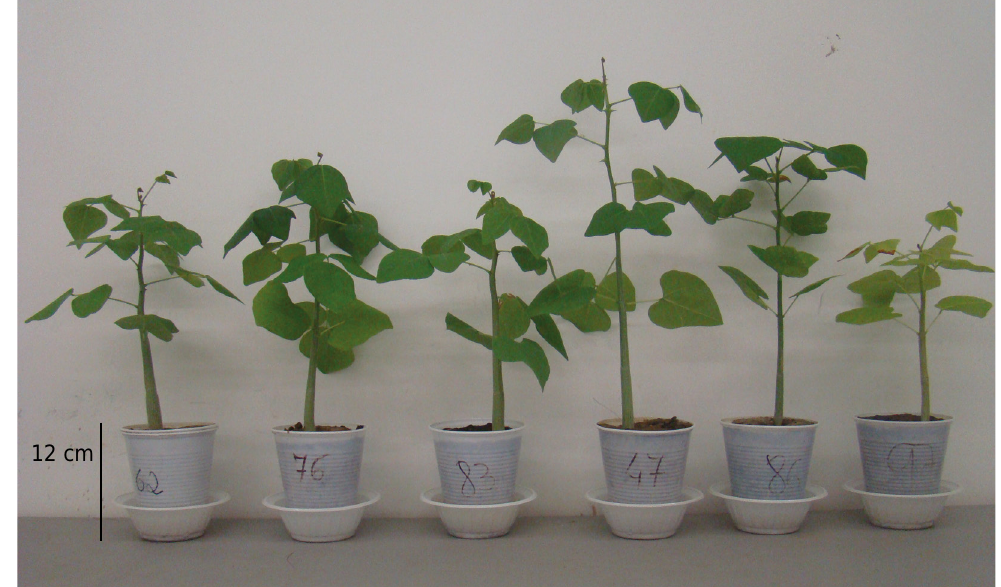
Figure 3. Plants of Erythrina velutina inoculated with different rhizobia at sowing, non-inoculated plants supplied with mineral nitrogen, or non-inoculated plants not supplied with nitrogen in an experiment using non-sterilized soil as a substrate, at 81 days after sowing. From left to right, the treatments are ESA 71, ESA 70, ESA 75, nitrogen supplied control, BR 5609, and an absolute